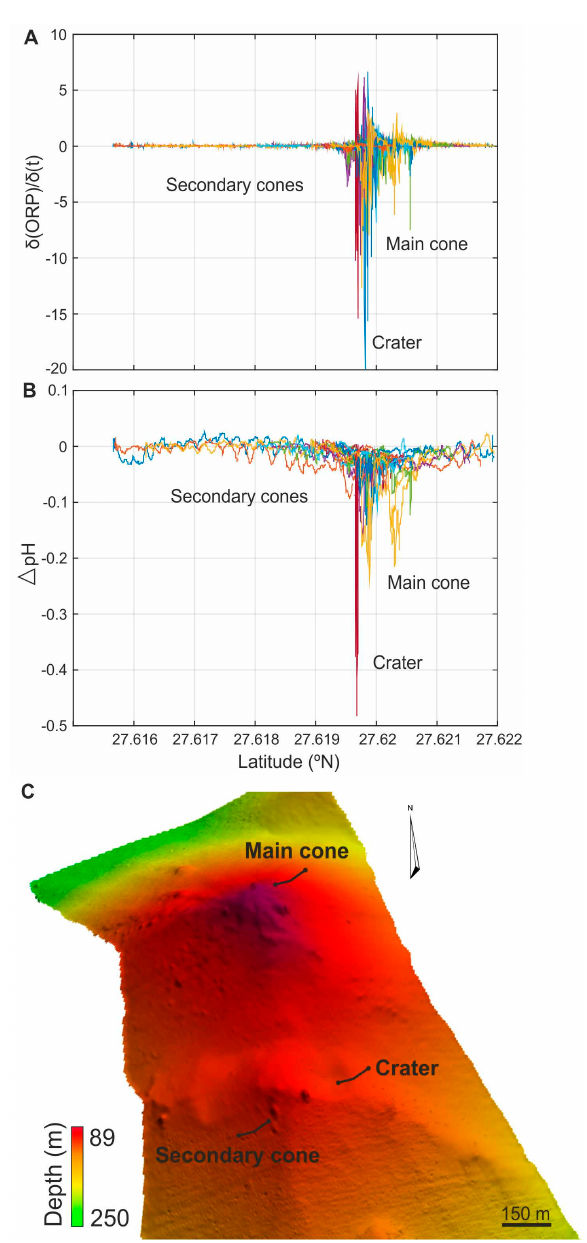
Figure 4. Plots of ( A ) Magnitude of oxidation-reduction potential (ORP) changes throughout time, δ (ORP)/ δ t and ( B ) The increment of pH, Δ pH, versus latitude obtained from different meridional tow-yo transects (colored lines) over the main volcanic edifice in October 2017, (methodology described in [9,10]. ( C ) Three-dimensional (3D) graph showing the main and secondary cones, as well as the crater.